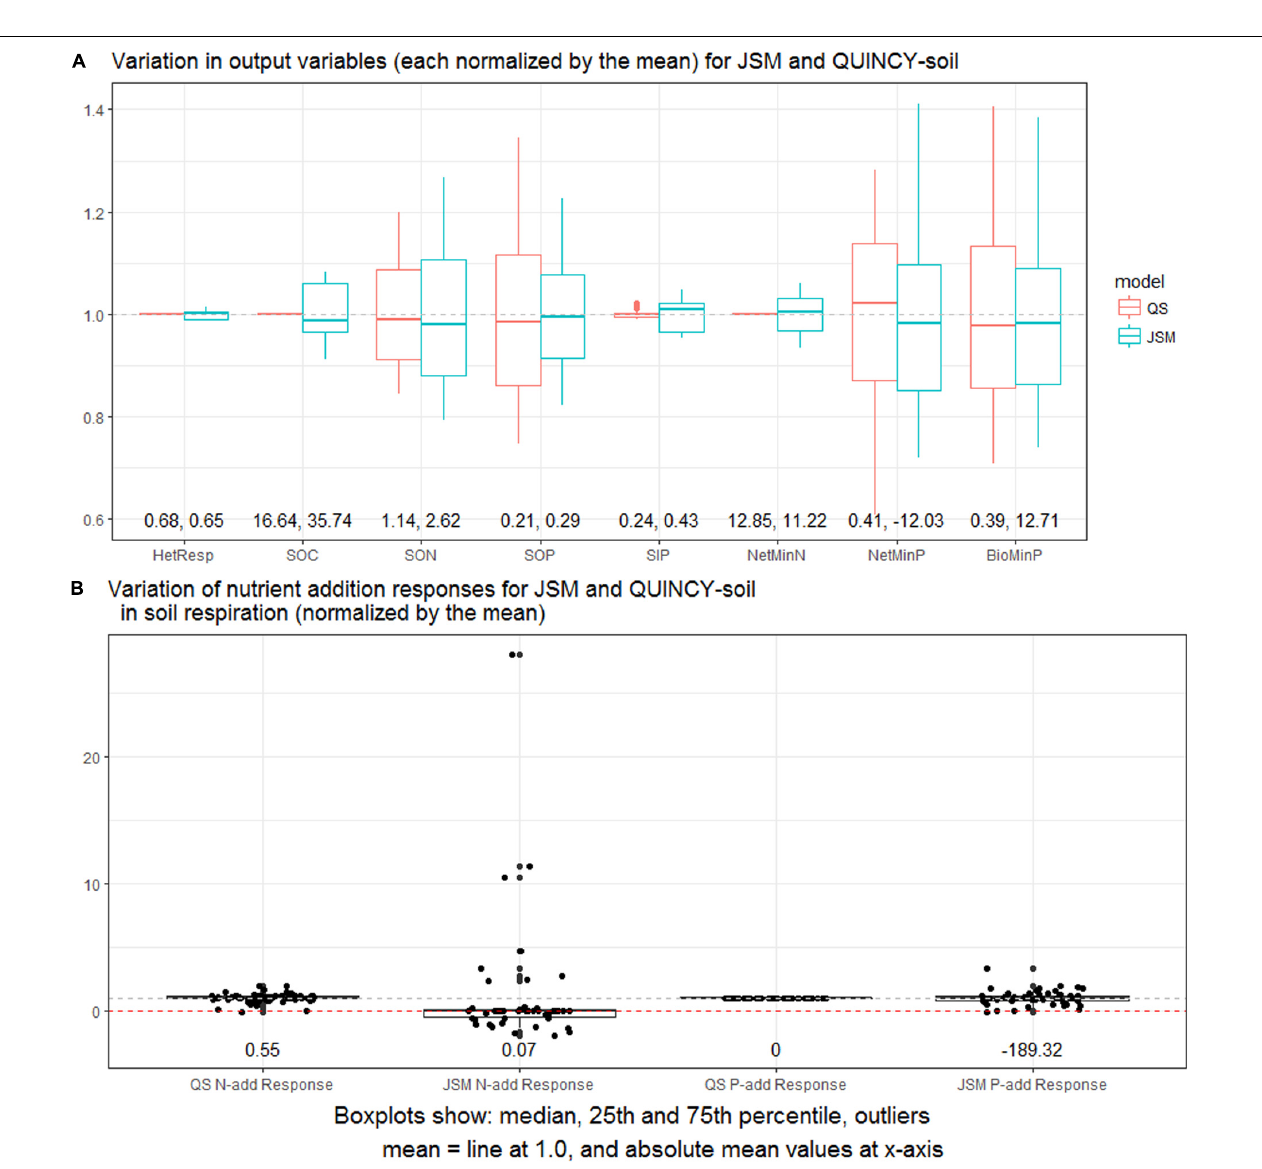
FIGURE 7 | (A) Normalized output variations in the LHS sensitivity analysis for JSM and QUINCY-soil (QS). The selected output variables include respiration, total soil organic C, N, and P, total soil inorganic P, net mineralization of N and P, and P bio-mineralization. (B) Normalized variations of soil respiration responses (mg C/year) to nutrient additions in the LHS sensitivity analysis for JSM and QUINCY-soil. The plots are based on data from the last 10 years of